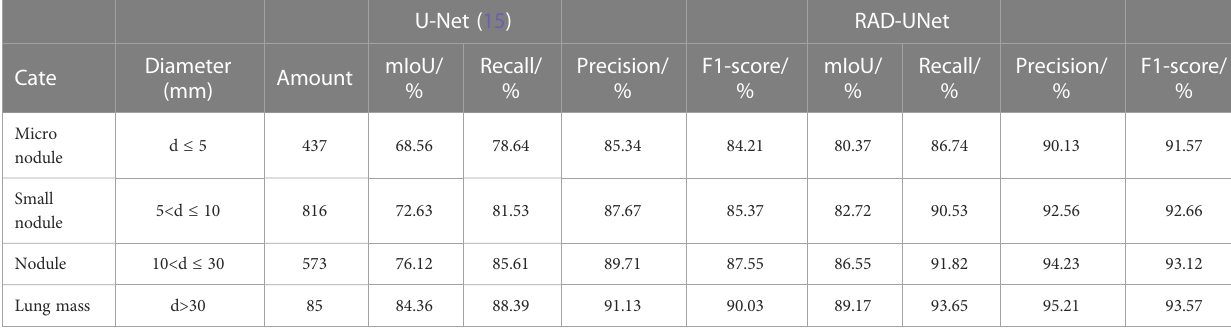
TABLE 3 Classi fi cation test segmentation results of lung nodules of different sizes using U-Net (15) and